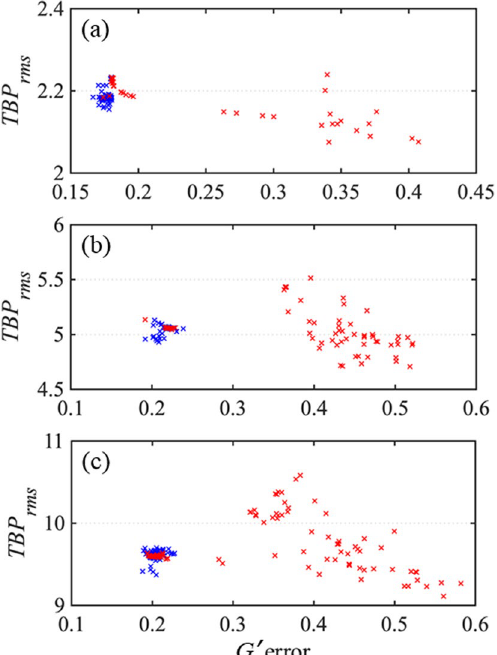
Figure 6. TBP rms for the retrieved pulses using the RANA approach and the GP algorithm vs. G ′ error are shown by blue and red crosses, respectively. The GP algorithm’s converged results have TBP rms close to the average of the train, while the stagnated results have varying TBP rms , and show more variations as the pulse trains become more complex. The retrieved fields using the RANA approach are precise, consistent, and close to the average values for the pulses in the three trains with ( a ) τ FWHM = 26 fs; TBP rms = 1.97, ( b ) τ FWHM = 54 fs; TBP rms = 4.75, and ( c ) τ FWHM = 108 fs; TBP rms = 9.28. (In ( a ), an outlier for a retrieval result of the GP algorithm is not shown. The TBP rms of the missing data is 4.6 with G ′ error of